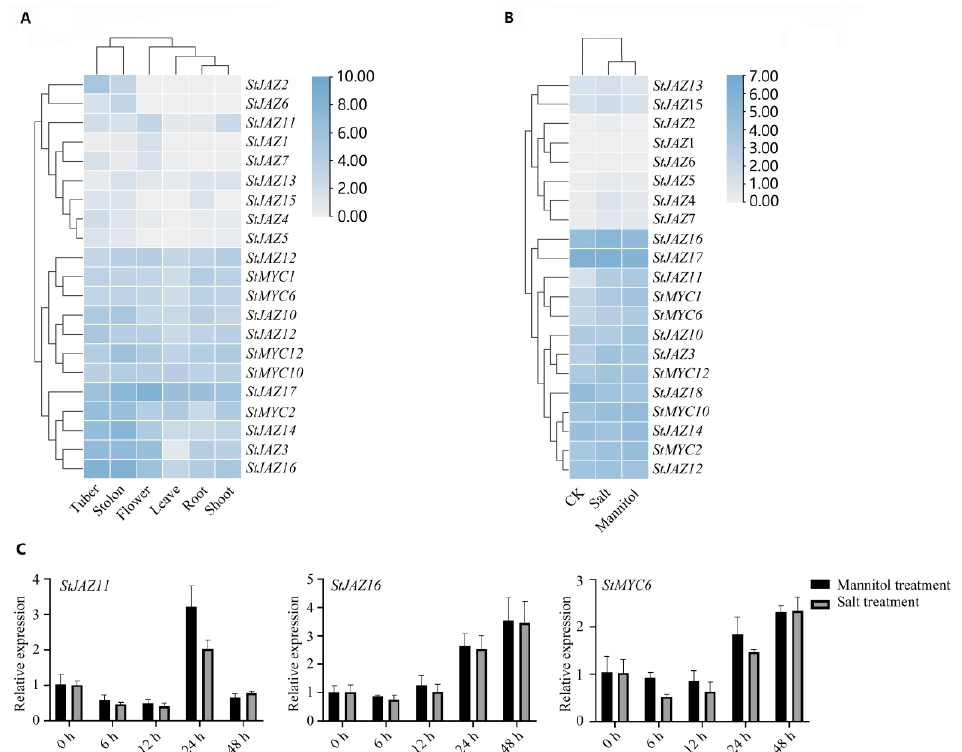
Figure 6. Expression patterns of StJAZ and StMYC genes with interactions and their responses to abiotic stress. ( A ) StJAZ and StMYC expression patterns in various tissues. ( B ) Expression patterns of StJAZs and StMYCs in different treatments. ( C ) Analysis of the expression of StJAZ11 , StJAZ16 , and StMYC6 by quantitative real-time (qRT)-PCR.